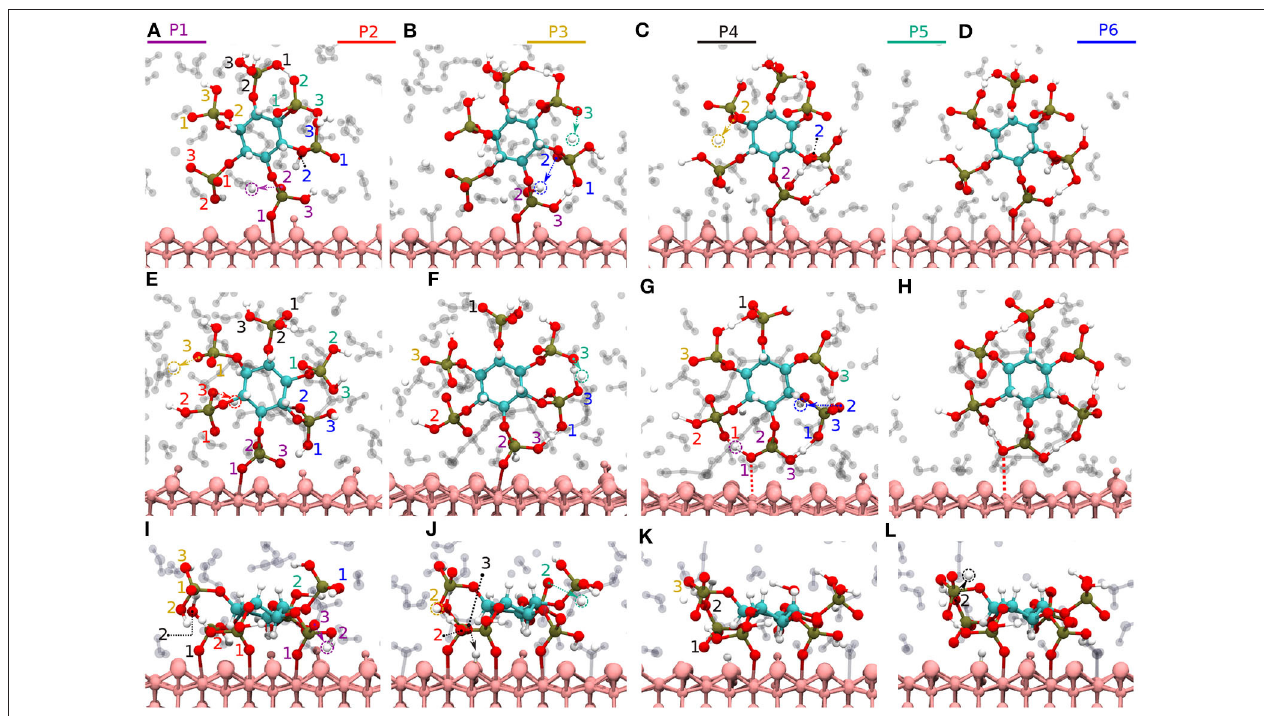
FIGURE 5 | Diaspore–IHP–water snapshots displaying proton transfer events and IHP dynamics along trajectories. The phosphate groups are color-coded and the oxygen atom label color denotes to the phosphate group it belongs. In M(1) motif, proton transfer from O12 to water (A) , proton transfer from O53 to water and intramolecular proton transfer from O62 to O12 (B) , moderately strong O12-H-O62 HB and proton sharing between O12 to O62 oxygens and proton transfer from O32 to water (C) , M(1) motif at 25 ps (D) . In M(2) motif, dissociation of Al2-O13 covalent bond due to O13-H-O61 HB and proton transfers from O23 and O33 to water (E) , proton transfer from O53 to water and formation of O53-H-O63 HB (F) , dissociation of Al1-O11 bond due to formation of O11-H-O21 HB (G) , M(2) motif at 25ps (H) . In 2M motif, dissociation of Al4-O51 bond and proton transfer from O13 to water (I) , proton transfer from O43 to diaspore and from O32 to water, also proton sharing and HB between O22 and O32 (J) , and between O33 and O42 followed by dissociation of Al3-O41 bond (K) , proton transfer from O42 to water and 2M motif at 25 ps (L) .